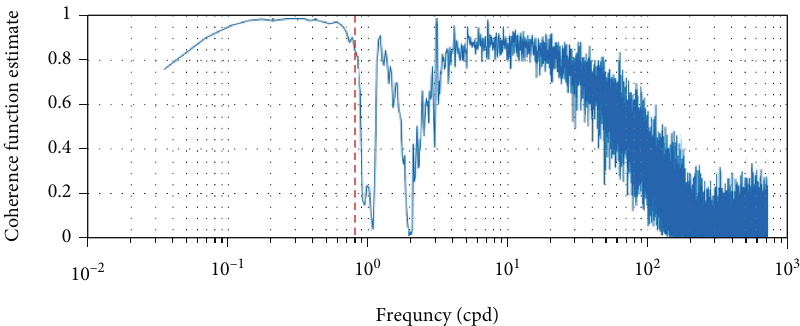
Figure 4: Coherence coe ffi cient of the barometric pressure and the processed water level. Data series of January 1st, 2017, to December 31th, 2017, were used to do coherence